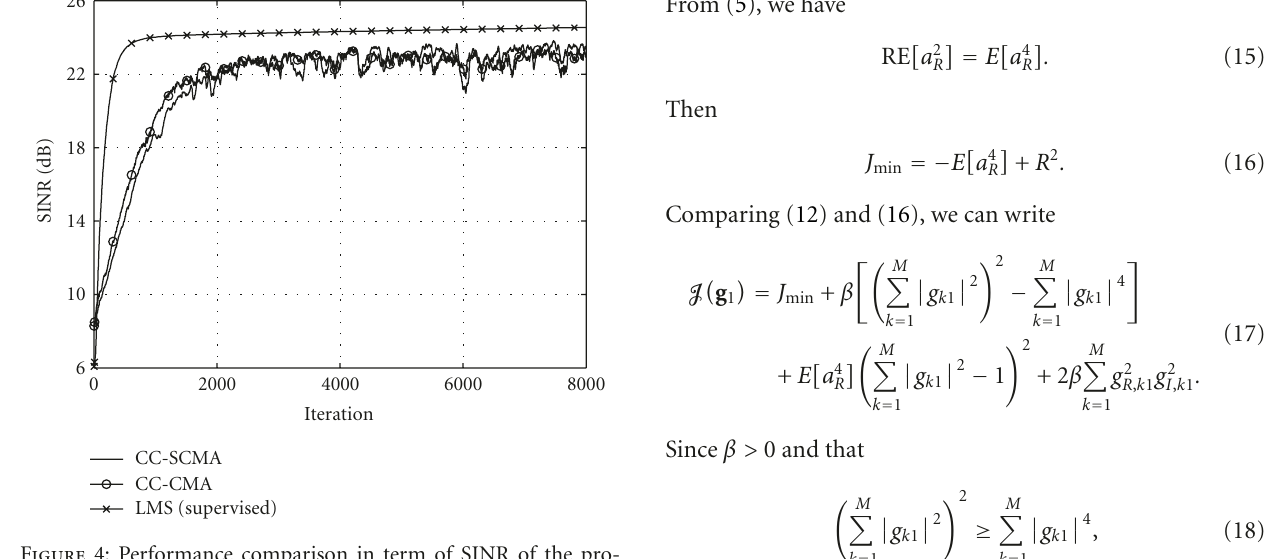
Figure 4: Performance comparison in term of SINR of the pro- posed algorithm (CC-SCMA) with CC-CMA and supervised